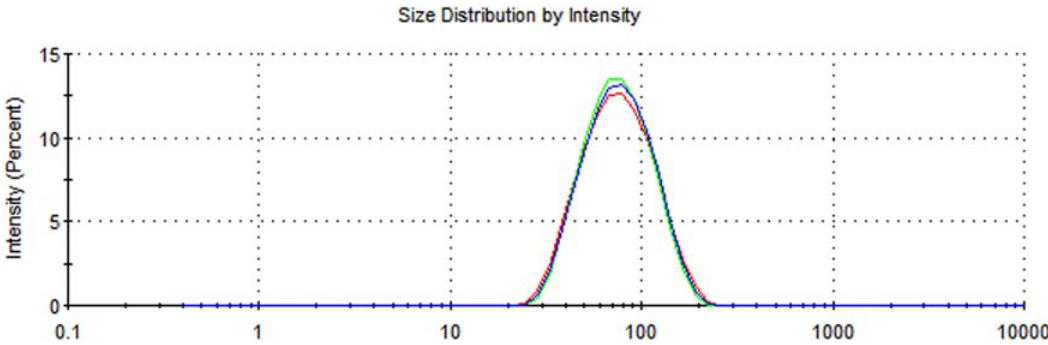
Figure 3: Average size of the biosynthesized AgNPs prepared with aqueous R. o ffi cinalis leaf extract.